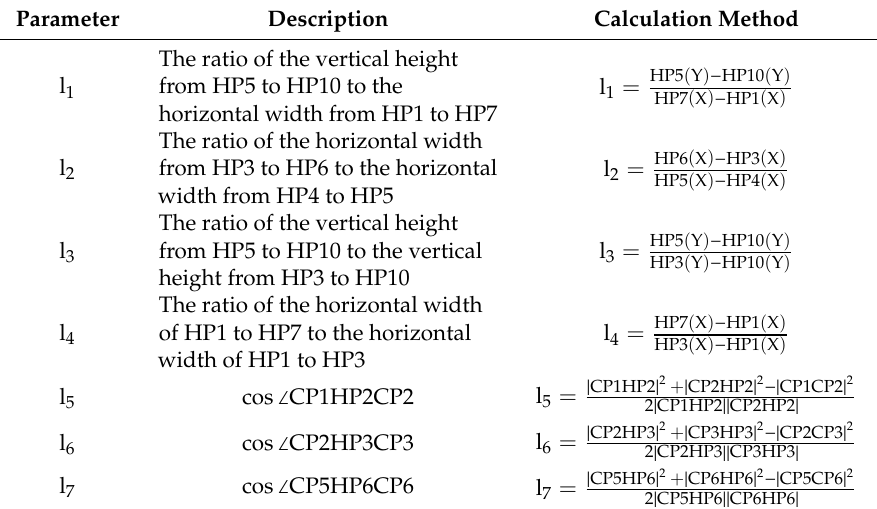
Table 1. Morphological feature